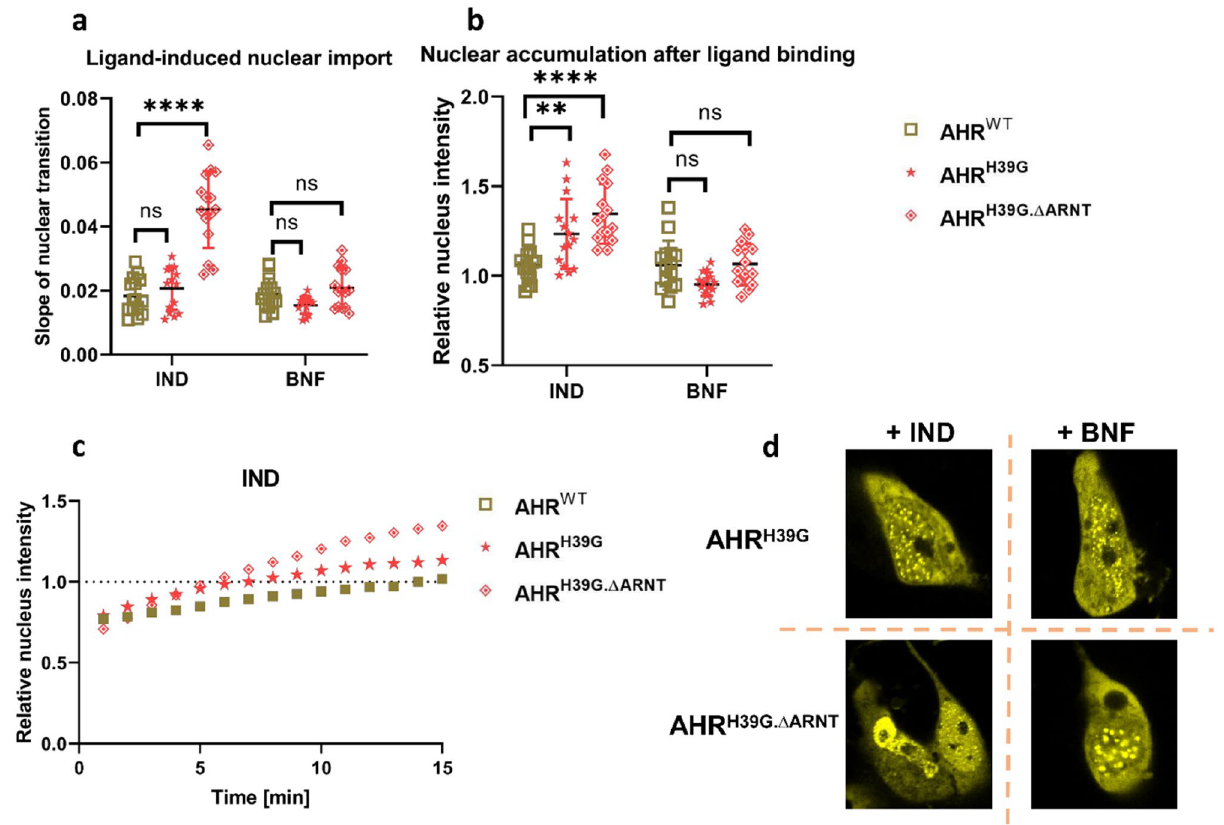
Figure 4. Forming the AHR-ARNT heterodimer and the active binding to the XRE is not decisive for stable ligand-dependent nuclear retention. ( a ) Slopes of nuclear transition of the AHR WT , AHR H39G and AHR H39G.∆ARNT after treatment with10µM indirubin (IND) or 10 µM β-naphthoflavone (BNF). ( b ) Nuclear accumulation of the AHR WT , AHR H39G and AHR H39G.∆ARNT 15 min after treatment with IND or BNF, respectively. Data display the individual values and the mean + /- S.D. of 15 cells (two way ANOVA, Dunnett’s multiple comparisons test, ** p < 0.01, *** p < 0.001). ( c ) Representative measurements of time-lapse experiments after stimulation with